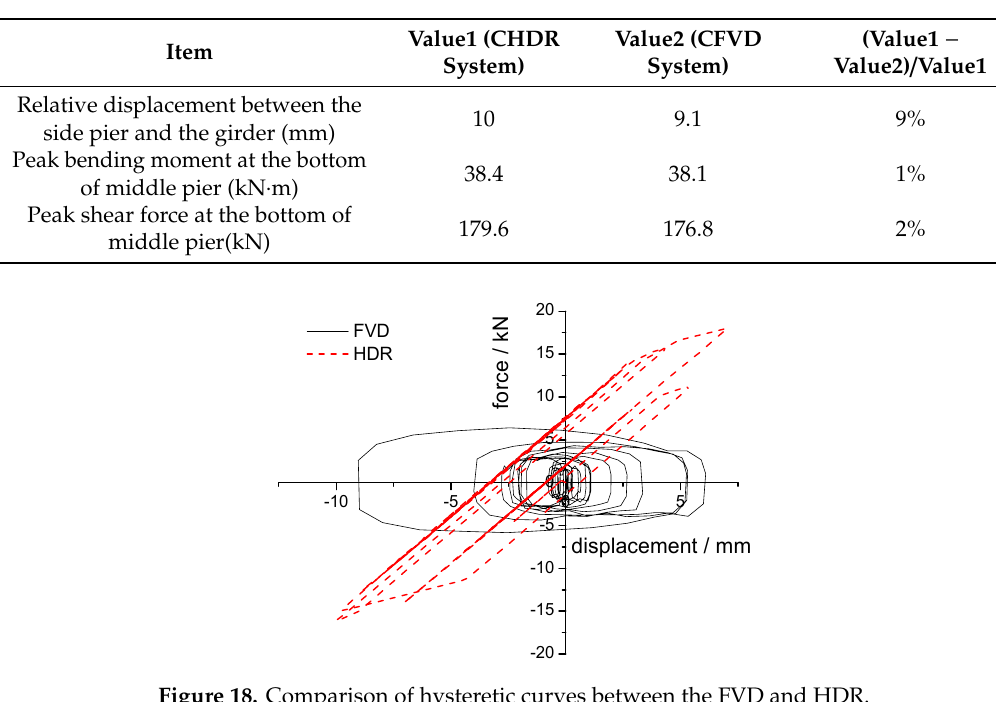
Figure 17. Relative displacement time history curve between side pier and girder of the CFVD system. Table 5. Comparison of seismic responses of two systems.